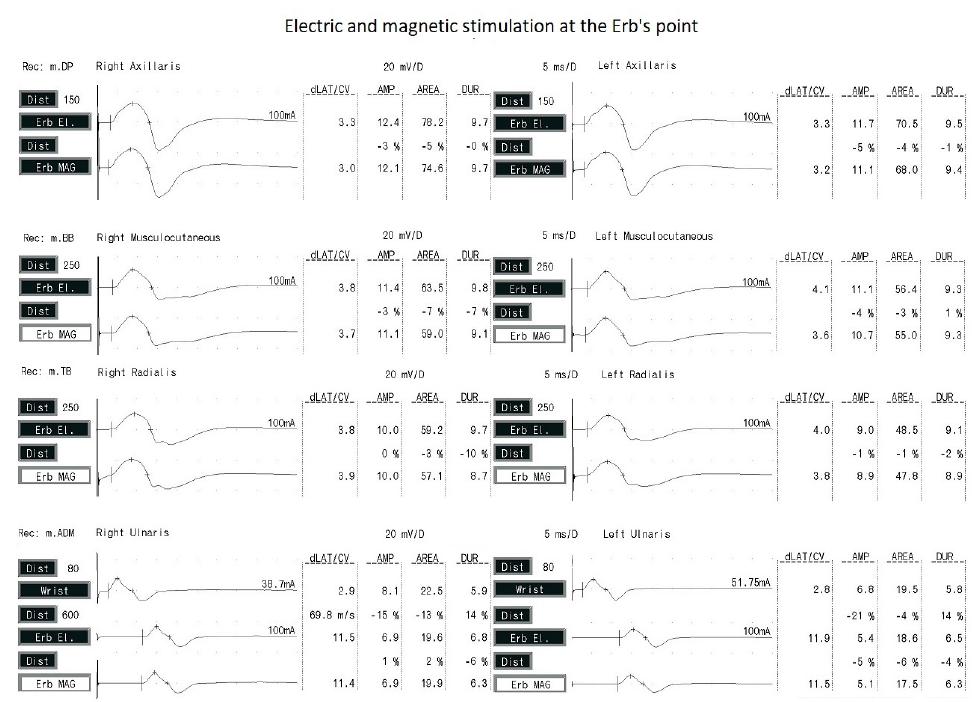
Figure 4. Examples of CMAP (upper traces) and MEP (lower traces) recordings after application of electrical and magnetic stimulation at Erb’s point on right and left sides. The distal point of ulnar nerve on the wrist was also stimulated (with electrical impulses only).